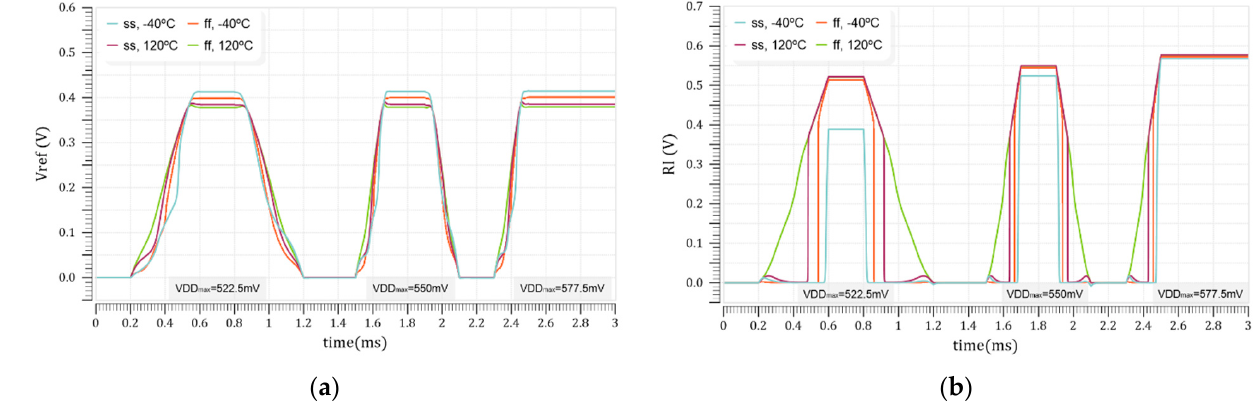
Figure 14. Simulation results for BGR#3 (65 nm, 550 mV) in PVT corners. ( a ) Vref , ( b ) RI.